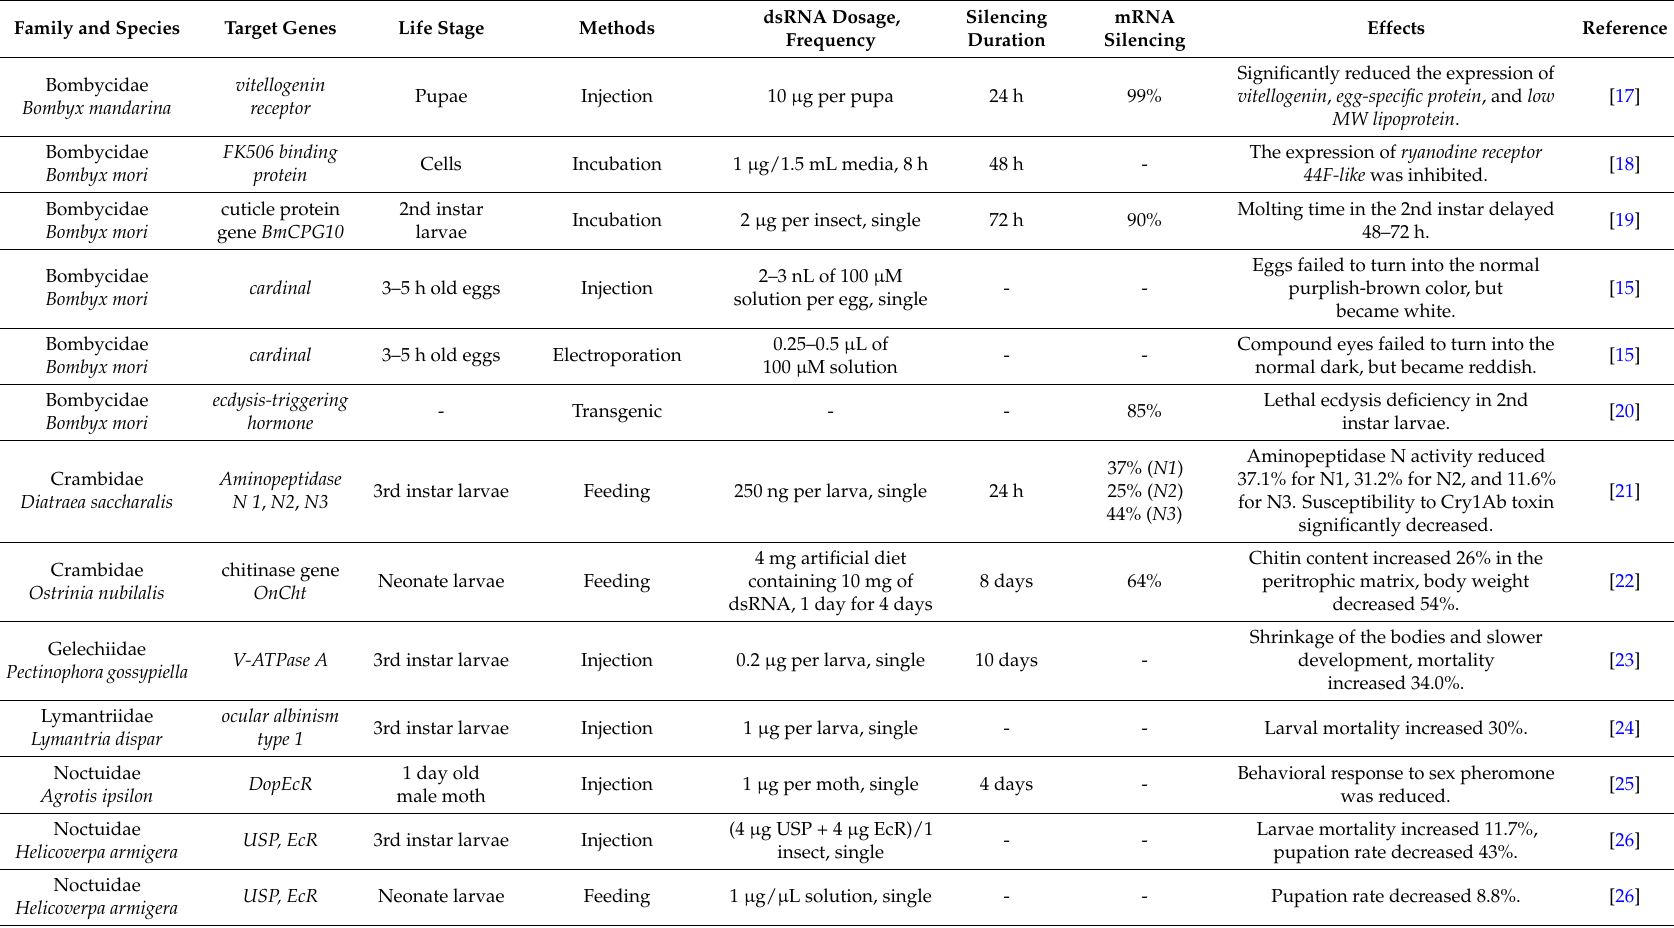
Table 1. Overview on use of RNA interference (RNAi) techniques for gene function analysis in